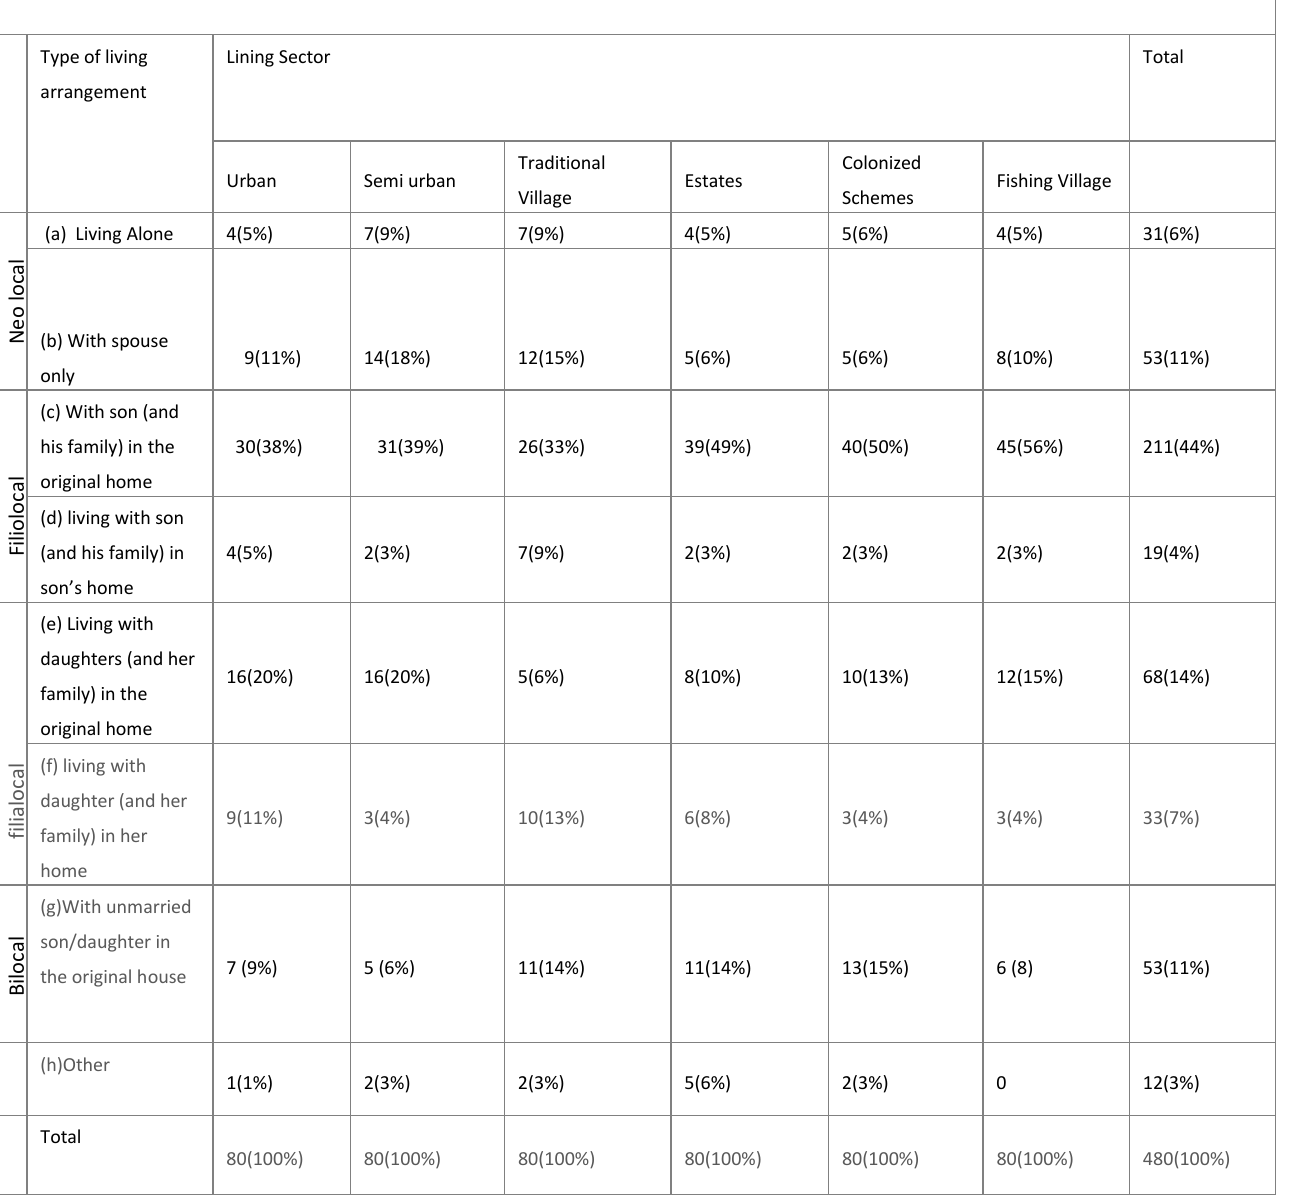
Table 2: Living arrangements of older persons (60 years and over) in sample communities